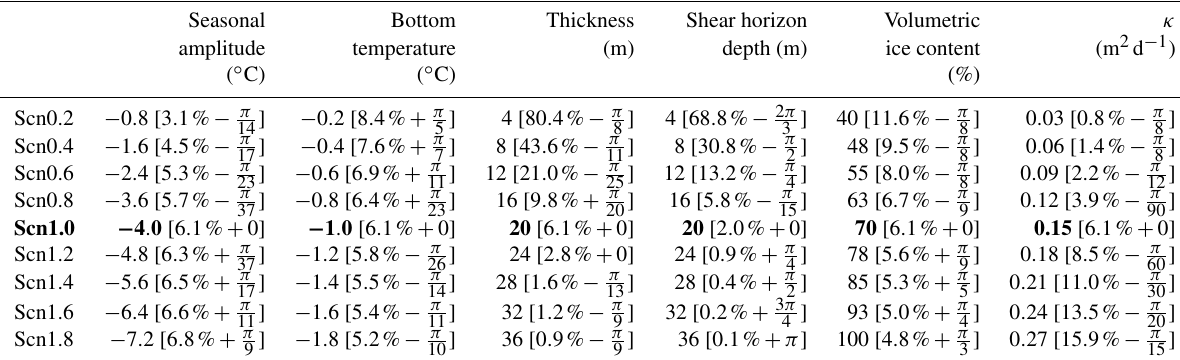
Table 3. Parameters and results of the sensitivity experiments. The first column indicates the scenario with a label in the form of Scn α , where α refers to the value of the multiplication factor for the investigated parameter relative to the reference values. Each column represents a set of experiments for one variable parameter, with the first number in each column referring to the input parameter value. The numbers in the bracket of each column refer to seasonal variations as a percentage of the mean value on the left side and the phase shift relative to the reference scenario on the right side (with a cycle of 2 π referring to 1